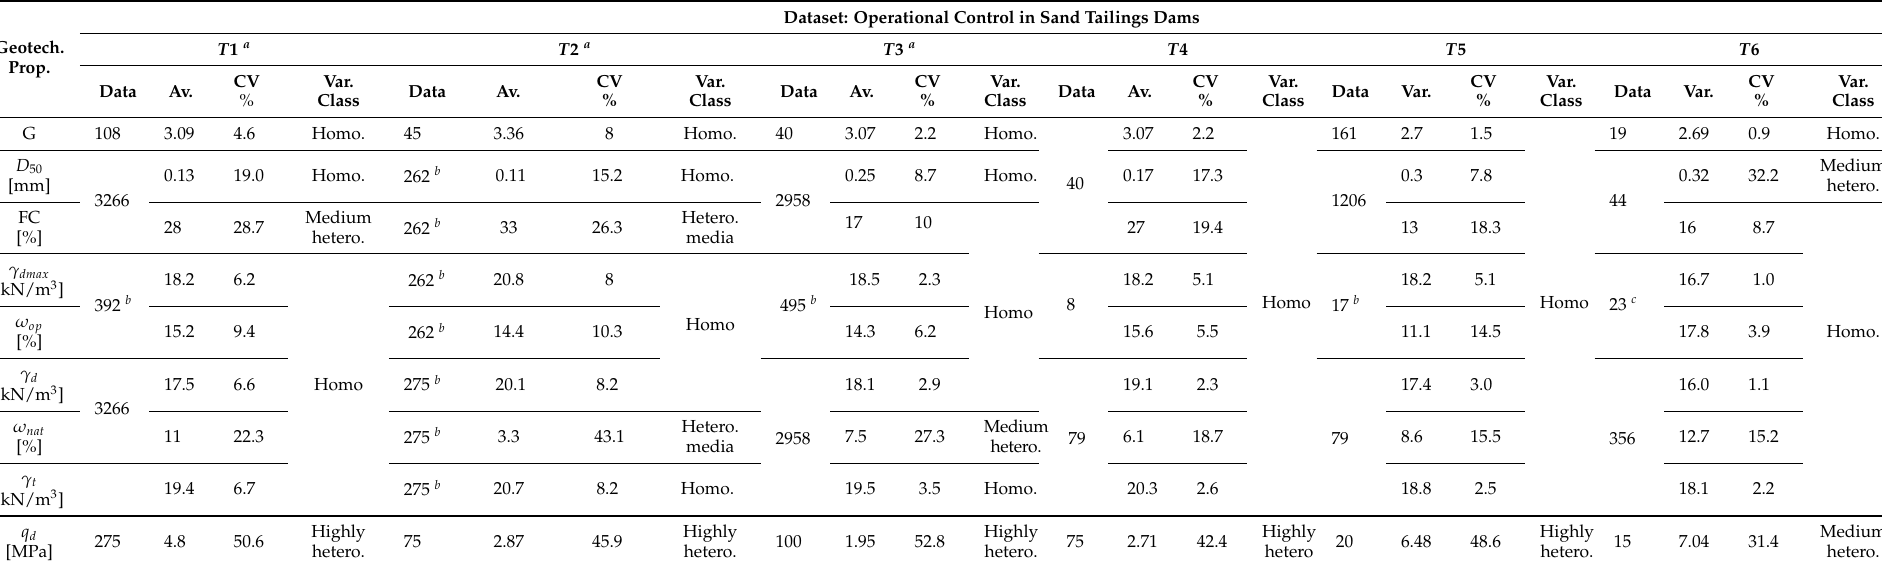
Table 3. Geotechnical properties of mine tailings based on statistical analyses of experimental data from Control compaction or quality control (QC) for six Chilean sand tailings